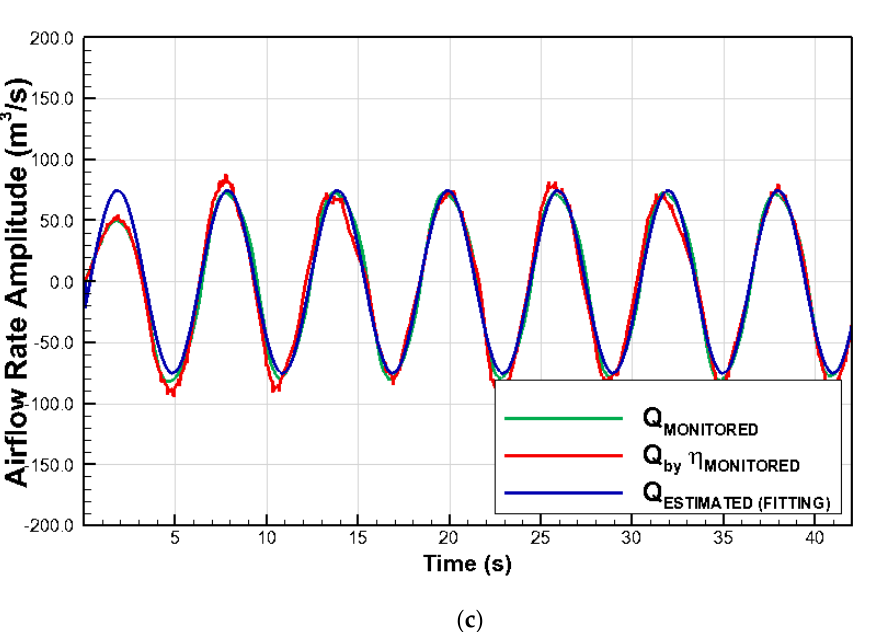
Figure 2. CFD simulation results for regular waves (T = 6.0 s, H = 1.0 m). ( a ) Comparison of pressure components; ( b ) Comparison of water elevations between measured and estimated amplitudes; ( c ) Comparison of airflow rate between measured and estimated amplitudes.